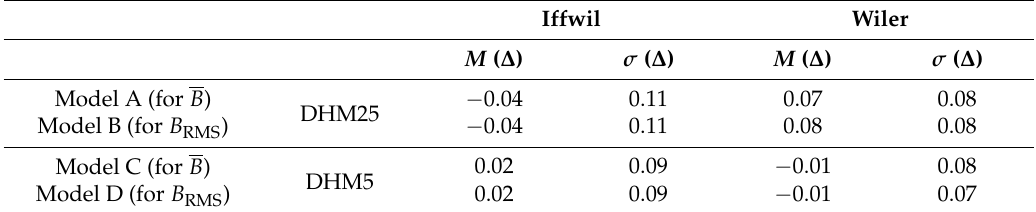
Table 2. Mean M ( ∆ ) and standard deviation σ ( ∆ ) of the difference between model and measurements for the models with the DHM25 (Models A and B) compared to those with the DHM5 (Models C and